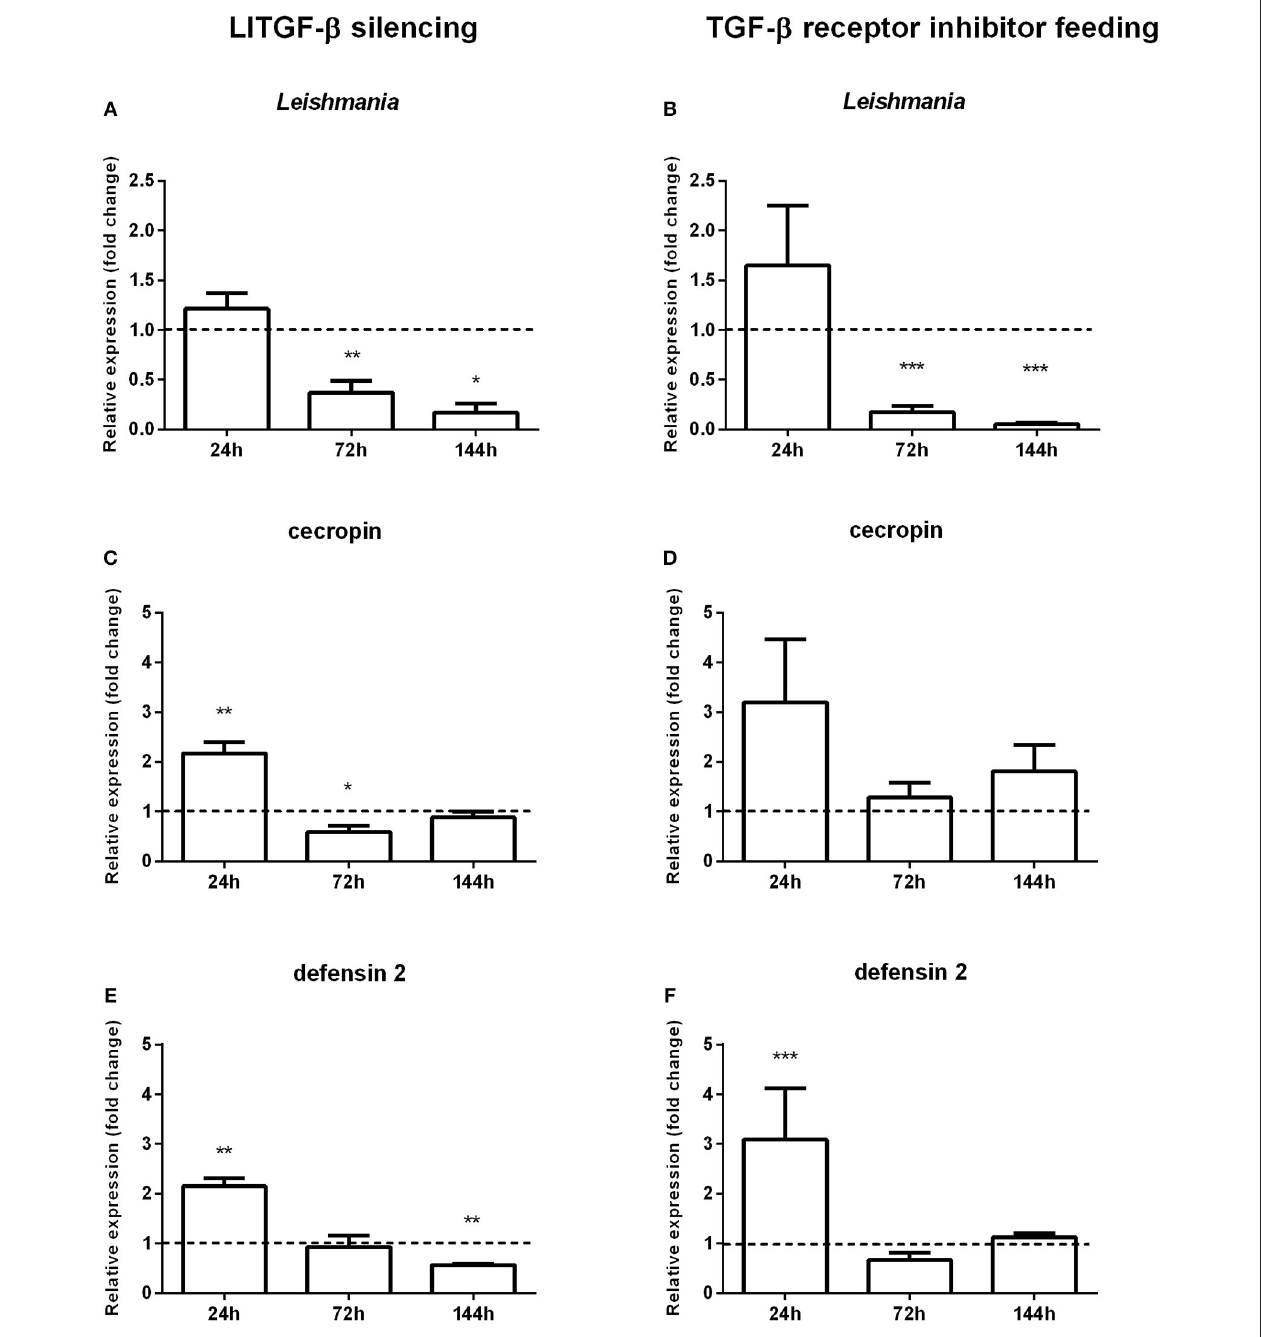
FIGURE 3 | Gene expression in sand flies infected by L. i. chagasi after abrogation of the LlTGF- β signaling pathway. (A,C,E) Gene expression of LlTGF- β silenced insects. (B,D,F) Gene expression of insects fed with TGF- β receptor inhibitor. (A,B) Quantification of L. i. chagasi in sand flies. (C,D) Relative expression of cecropin. (E,F) Relative expression of defensin 2. Samples were collected at 24, 72, and 144h post infection. Dotted lines indicate gene expression of β -galactosidase dsRNA injected (A,C,E) or DMSO fed flies (B,D,F) control groups, or. Both test and control groups were infected by L. i. chagasi . Comparisons were done between silenced vs. non-silenced, or inhibitor treated vs. non-treated sand fly groups. Bars represent mean with standard error of fold change in gene expression relative to control groups of 3 independent experiments. Significant differences were evaluated by t -test and Mann–Whitney post-test (* p < 0.05; ** p < 0.01; *** p < 0.001). incubation of recombinant TGF- β with L. braziliensis infected anti-TGF- β a pro-inflammatory environment was created with macrophages increased parasite loads (Barral et al., 1995). In an consequent decrease of parasite numbers at the lesion site (Li et al., 2018). In addition, in vitro assays showed that the inflammatory situation, Toll-like receptors (TLRs) mediate the